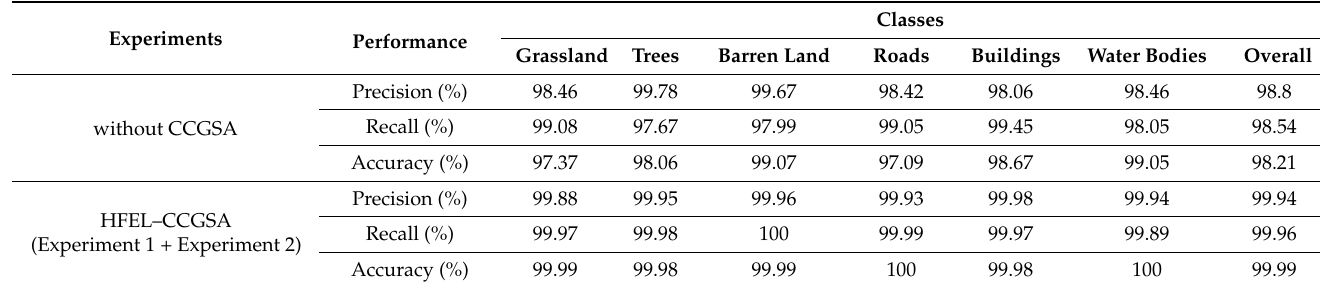
Table 4. Performance analysis for ‘without CCGSA’ and HFEL–CCGSA method on SAT-6 dataset.